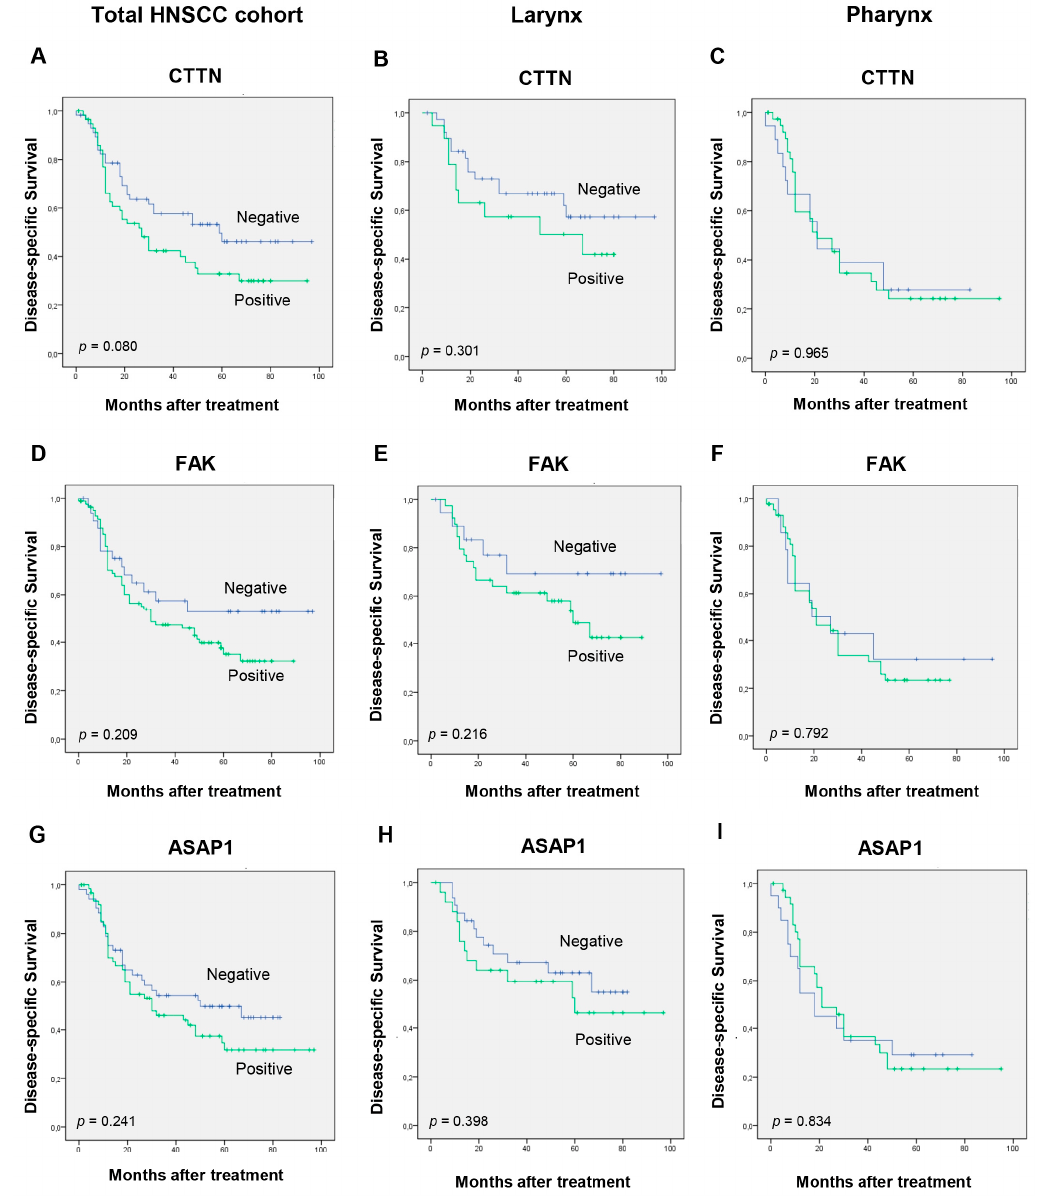
Figure 4. Impact of SRC-related proteins on patient survival. Kaplan–Meier disease-specific survival curves categorized by CTTN expression ( A–C ), FAK expression ( D–F ), and ASAP1 expression ( G–I ) in the total cohort of HNSCC patients or in the laryngeal and pharyngeal subgroups. p values were estimated using the log-rank test.